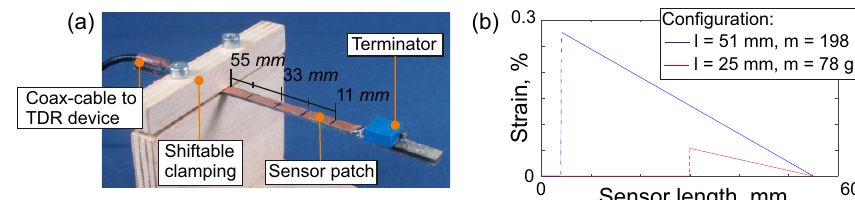
Figure 2. Clamped sensor patch in test device with a free bending length of 55mm (a) and idealized strain profiles and an example shown for two configurations with different bending lengths and loading weights (b) .